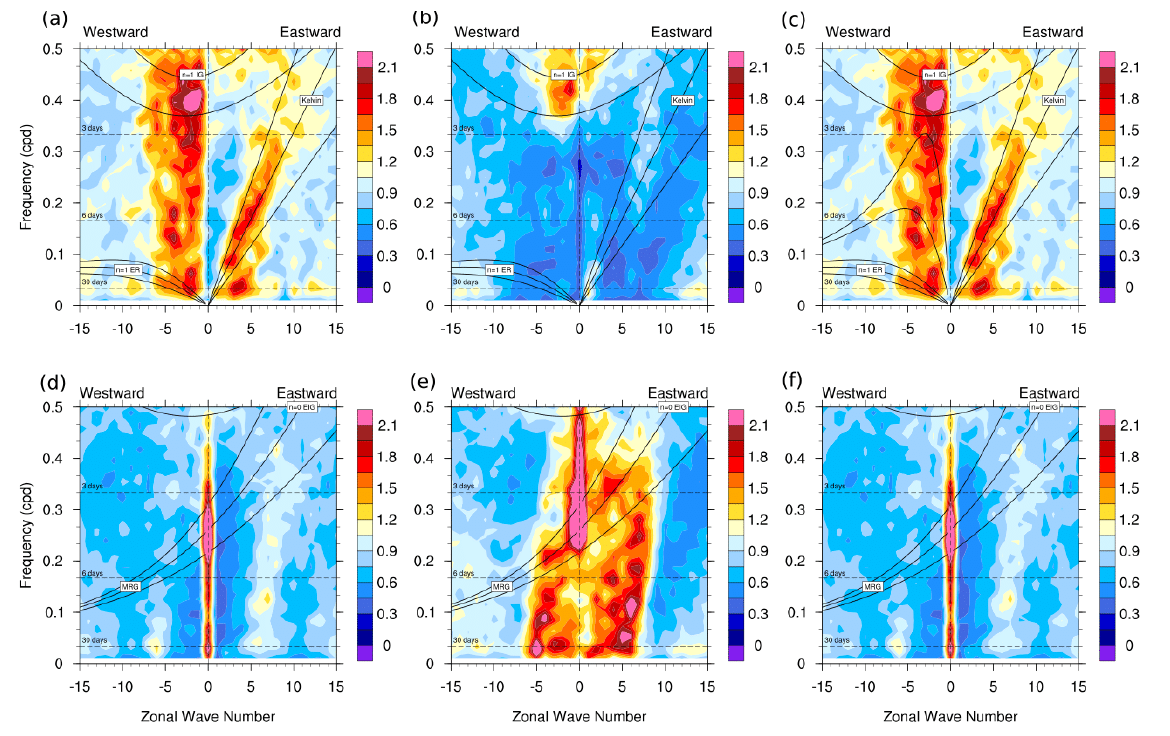
Figure 9. Wavenumber-frequency spectrum of the 200 hPa meridional wind field associated with the westward inertio-gravity modes. Panels ( a – c ) refer to the antisymmetric part, while panels ( d – f ) refer to the symmetric component of the meridional wind field. The full spectrum of vertical modes is presented in panels ( a , d ), the barotropic component of the corresponding parts is displayed in panels ( b , e ), and the baroclinic component is illustrated in panels ( c , f ). Recall that the symmetric (antisymmetric) component of the meridional wind field corresponds to the antisymmetric (symmetric) modes.